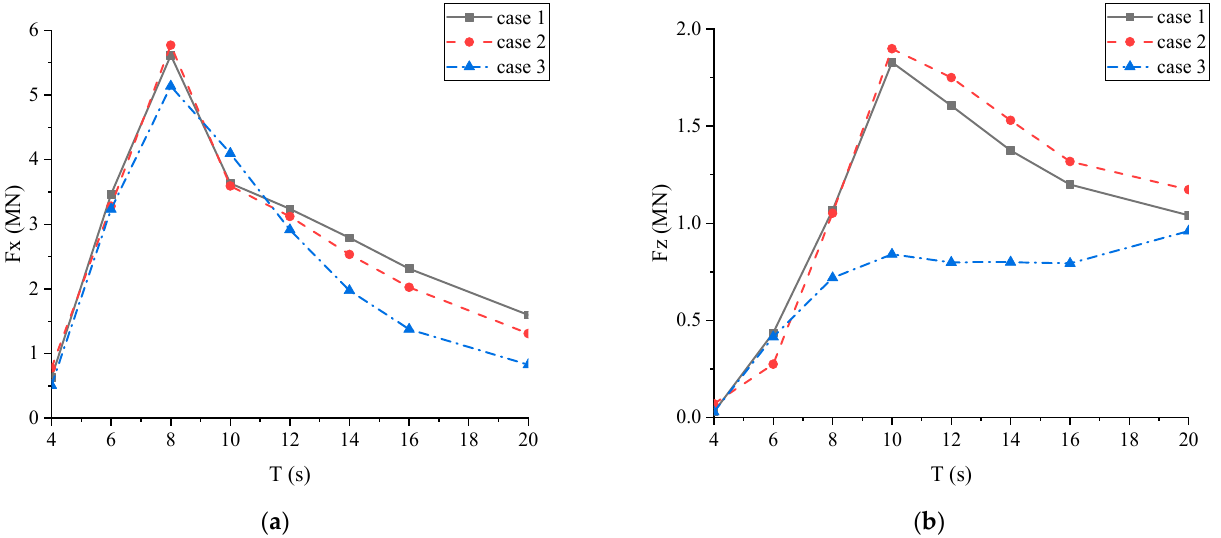
Figure 12. Main loads of the first connector between adjacent hexagonal modules in head sea under different layouts: ( a ) horizontal force; ( b ) shear force.